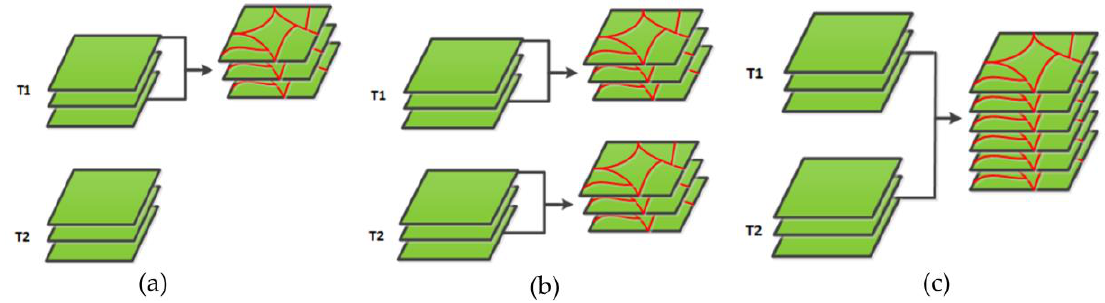
Figure 3. Multi-temporal image segmentation modes. ( a ) STS; ( b ) MTSS; ( c ) MTCS.